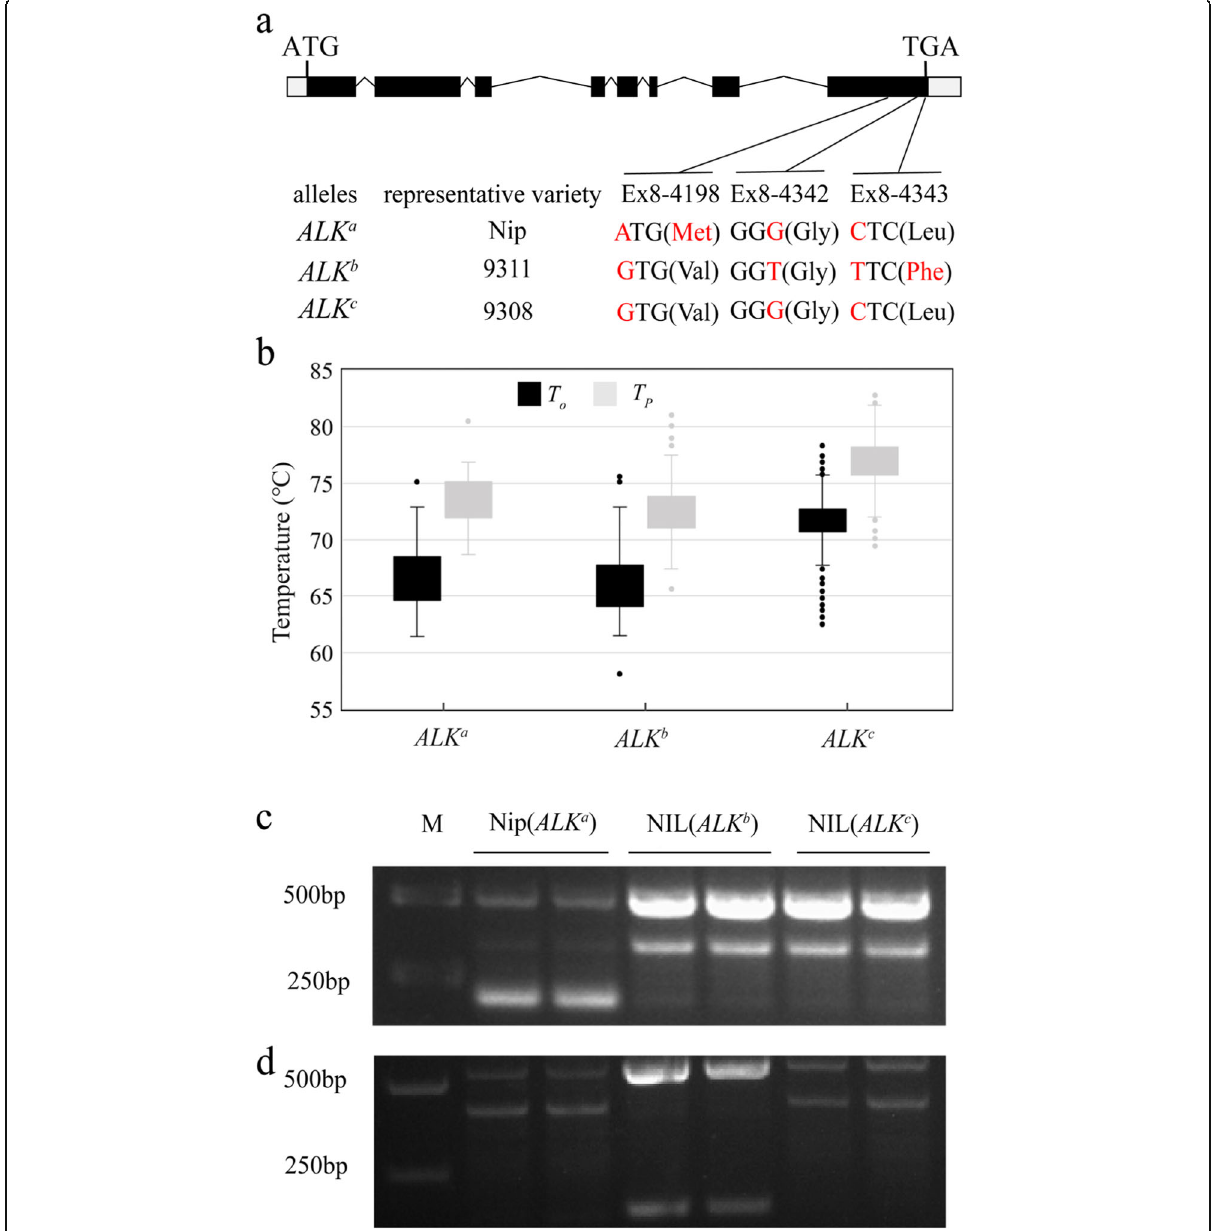
Fig. 1 Natural variation and three main alleles of ALK gene in rice. a Schematic representation of ALK coding regions and its three main alleles classified by three single nucleotide polymorphisms (SNPs, shown in red letters) in exon 8. The start (ATG) and stop (TGA) codons were shown. Nip represents the rice cultivar Nipponbare. b The average gelatinization temperatures of rice grains with different ALK alleles among 399 rice accessions. T o and T p were the onset and peak temperatures during gelatinization measured by differential scanning calorimeter (DSC), respectively. c and d Confirmation of near-isogenic lines (NILs) carrying different ALK alleles by two functional molecular markers 4211 (G/A) ( c ) and 4342 (GC/TT) ( d ) by using the allele-specific PCR (AS-PCR),